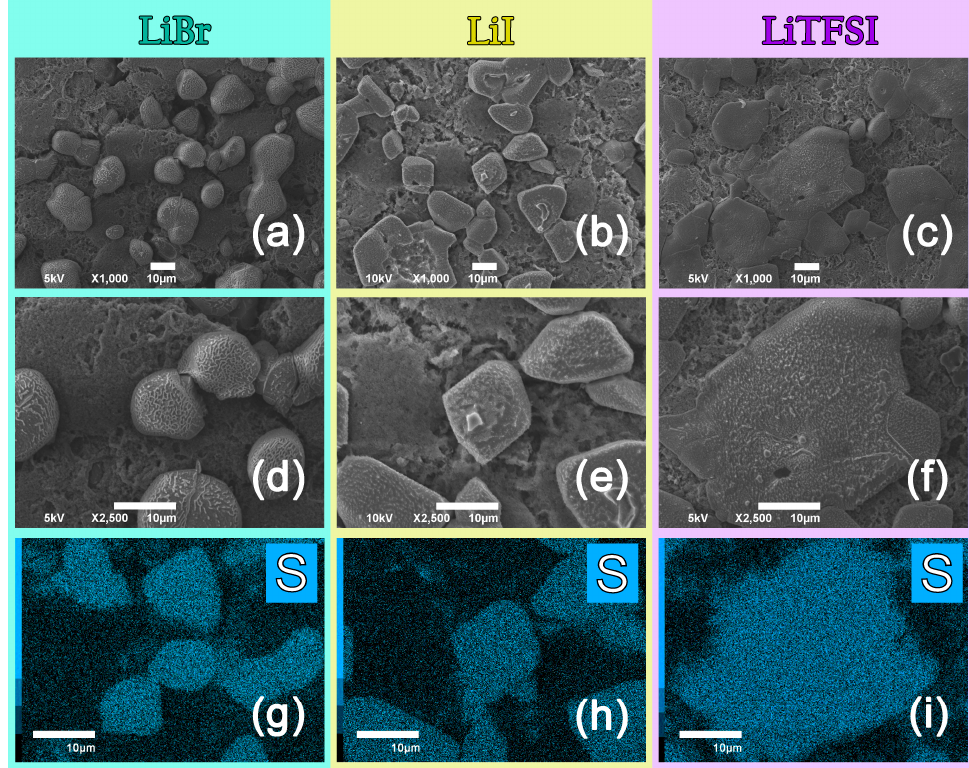
Figure 6. SEM images at different magnifications of the Li 2 S morphology on the post-mortem sulfur electrodes using ( a , d , g ) LiBr, ( b , e , h ) LiI, and ( c , f , i ) LiTFSI electrolytes, respectively. The relative EDX maps are reported in figure ( g , h , i ).